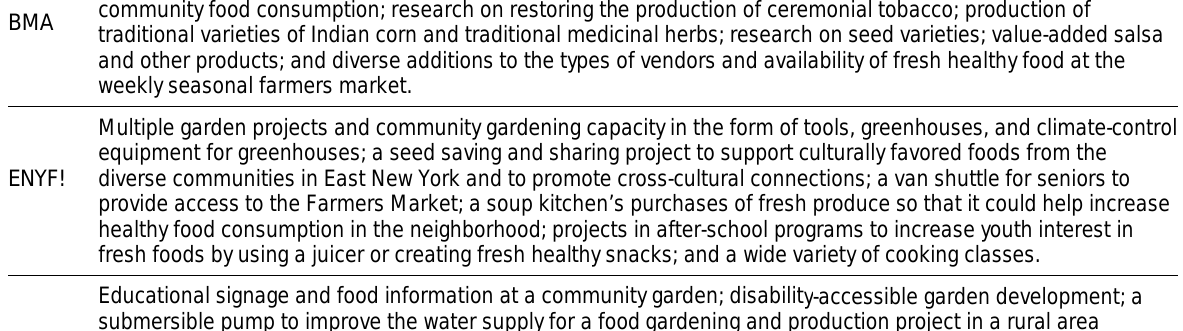
Table 4. Funded Minigrant Projects for Each Organization